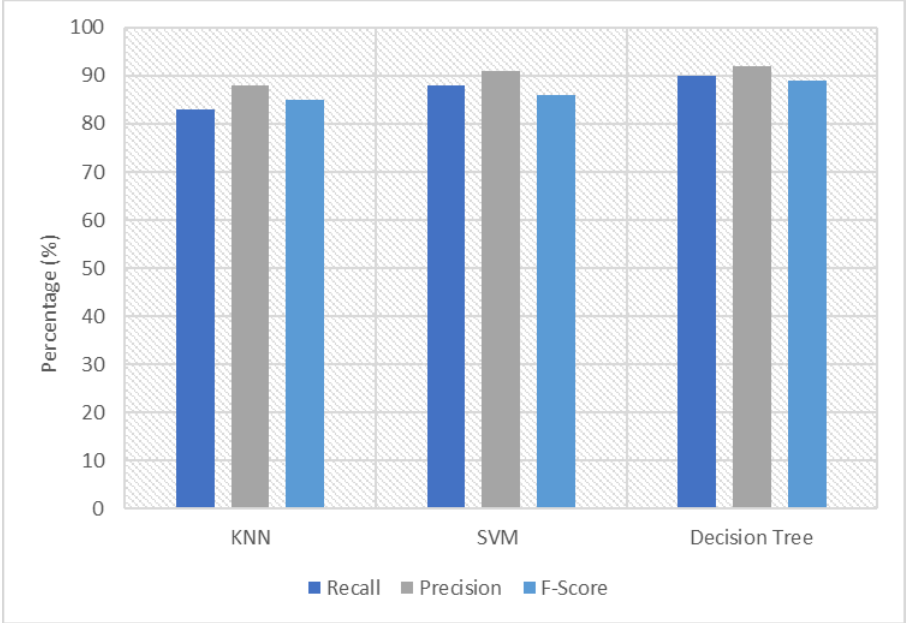
Figure 5. Performance analysis — Recall, Precision, and F-score.